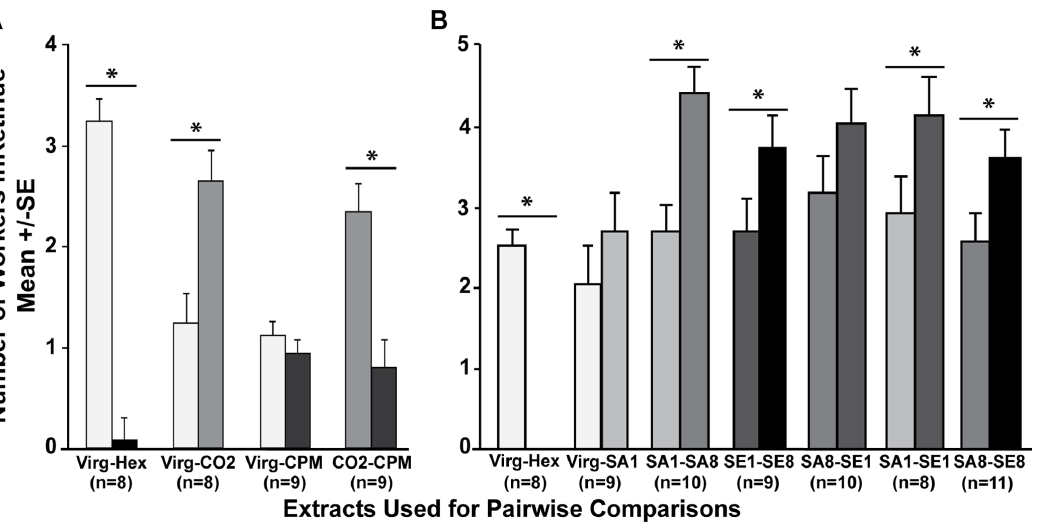
Figure 4. Assay of Behavioral Responses to Mandibular Gland Extracts. Caged groups of 30 five-day-old workers were presented queen mandibular gland extracts from two different queen groups. The number of workers in each cage antennating and/or licking the two extracts were counted every five minutes over a 40-minute period and for two consecutive days. Statistical differences in the preferences for one extract versus the other in the pairwise comparisons were determined via repeated measures ANOVA with treatment as the main effect and day as a repeated variable. The mean 6 SE is shown for the raw data, an asterisk above the bars indicates statistically significant differences; n is the number of cages used in comparison. A ) In the first experiment we tested workers’ preference for extracts of Virg, CO 2 , and CPM queens. B ) In the second experiment we tested workers’ preference for extracts of Virg, SA1, SA8, SE1, and SE8 queens.